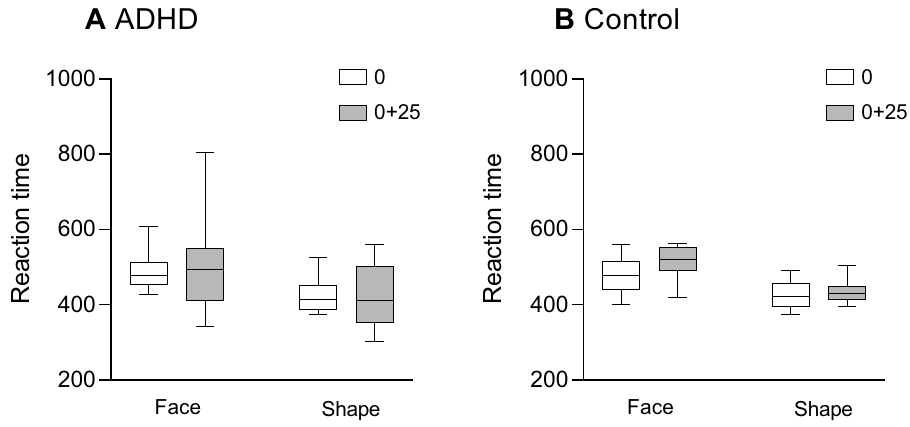
Figure 2. Boxplot (median, minimum–maximum) of the reaction times (RT) in response to target (angry) faces or target shapes for the ADHD group (A) and the control group (B).